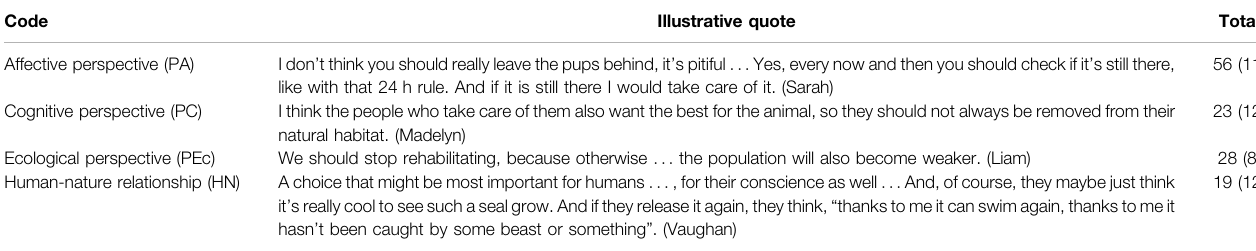
TABLE 5 | Students ’ morality regarding their ethical sensitivity ( n (cid:1) 12). Code